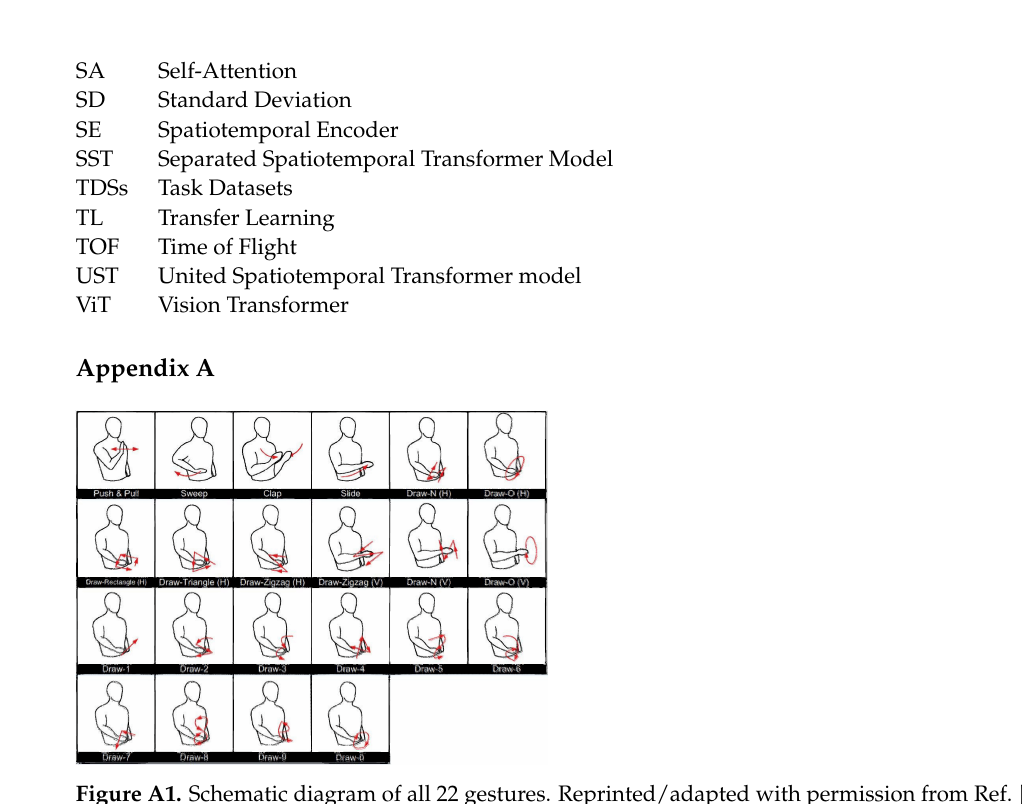
Figure A1. Schematic diagram of all 22 gestures. Reprinted/adapted with permission from Ref. [60]. 2020,